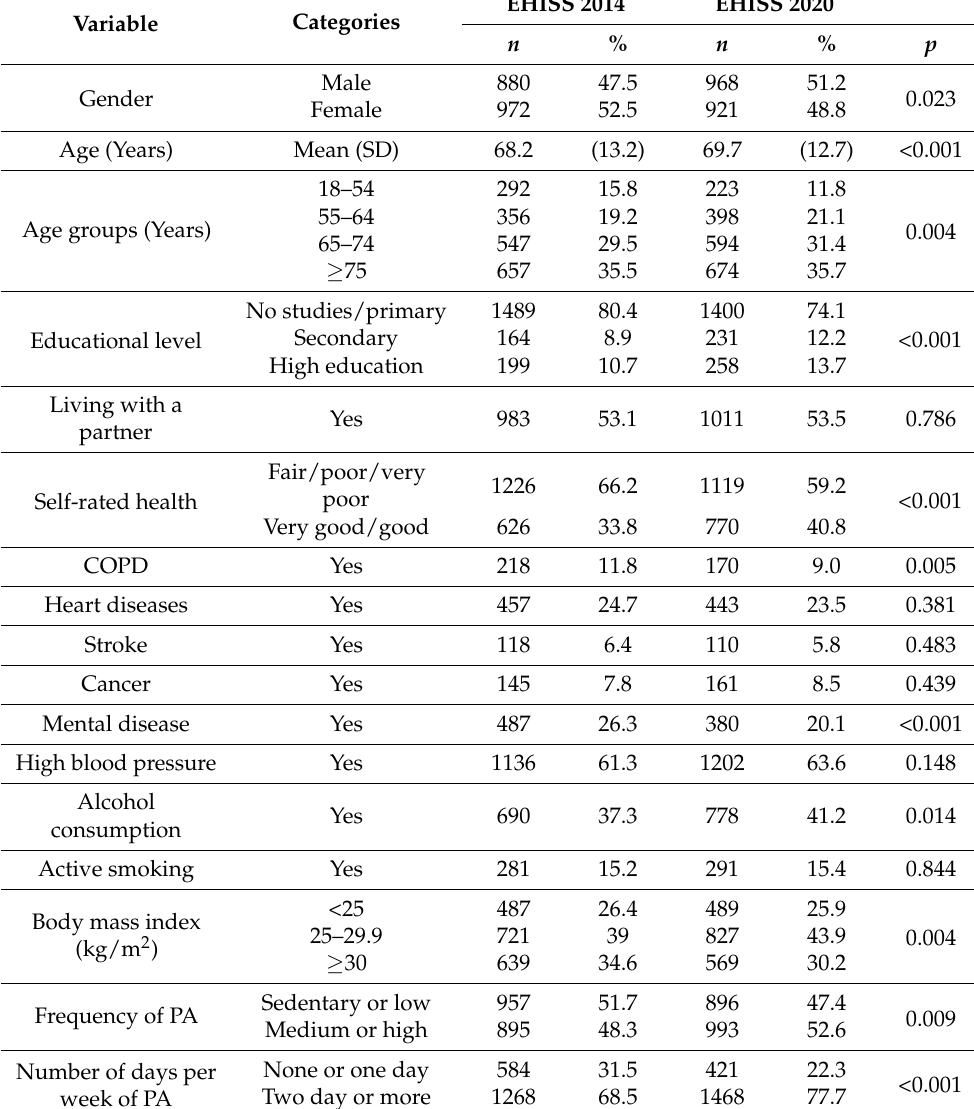
Table 1. Distribution according to study variables of people with self-reported diabetes included in the European Health Interview Surveys for Spain (EHISS) conducted in years 2014 and 2020.